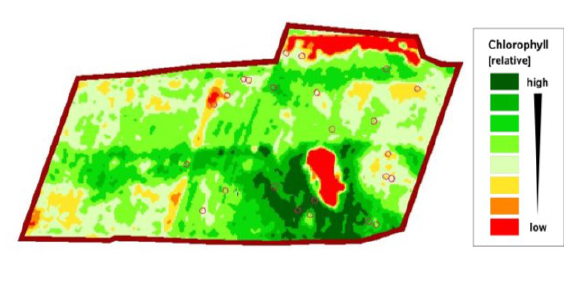
Figure 2. Spatial distribution of classes representing relative chlorophyll level differences in winter wheat on 7 th of May